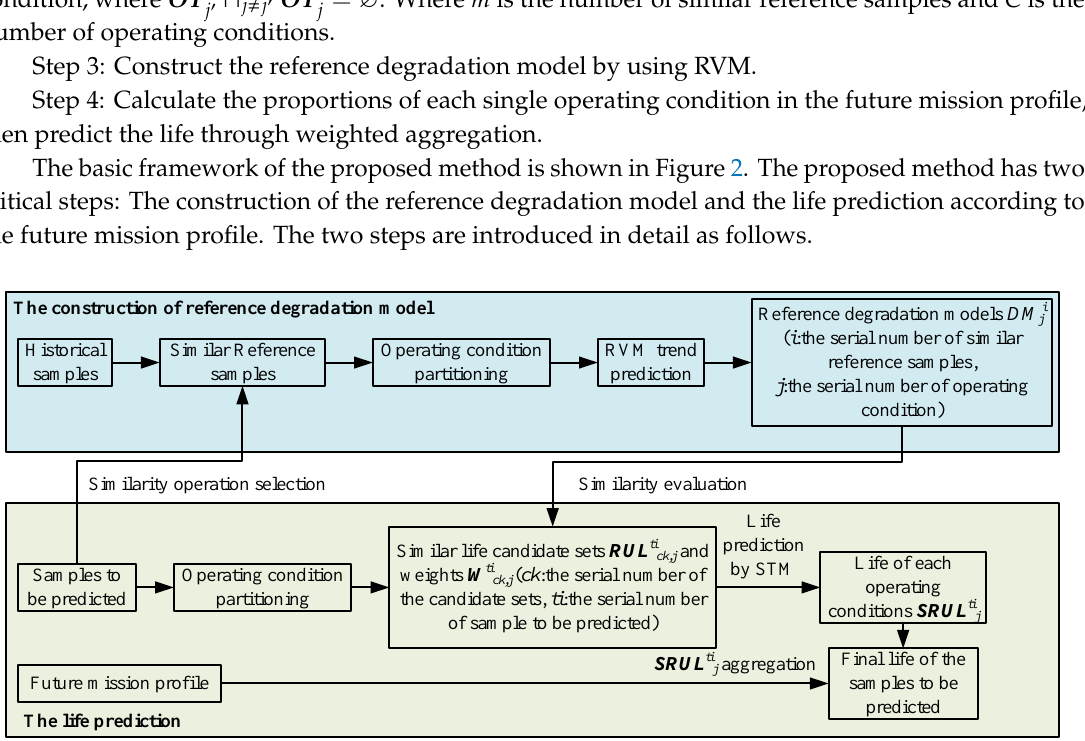
Figure 2. The process of the proposed method. The proposed method consists of two main processes: The construction of the reference degradation model and the life prediction. RVM, relevance vector machine.